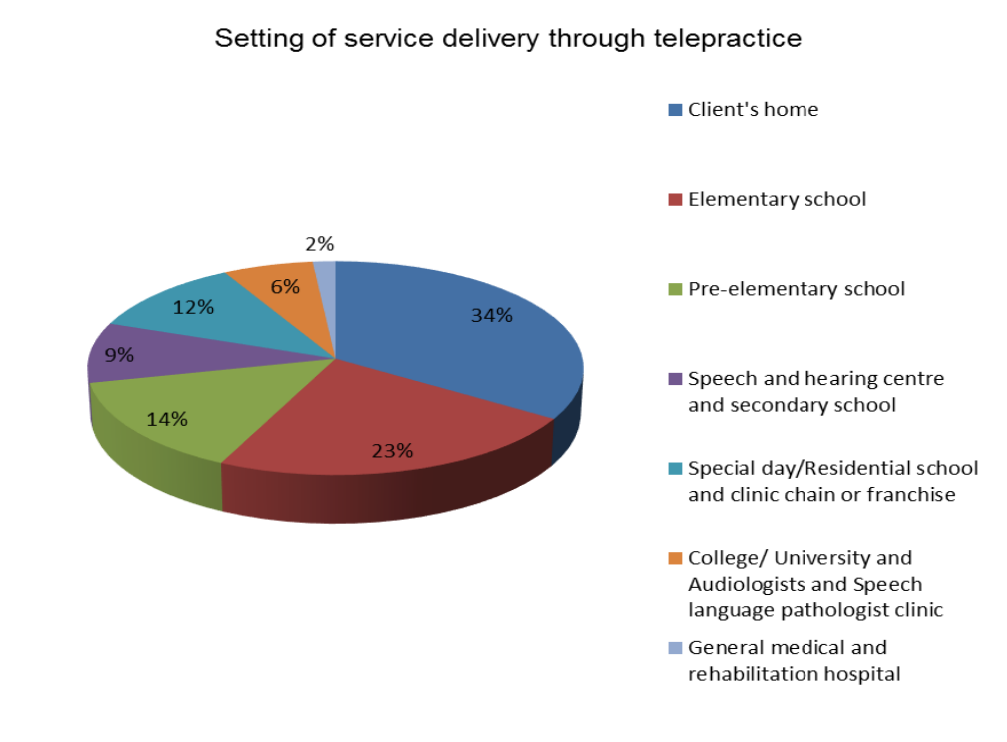
Figure 2. Settings of service delivery through telepractice.